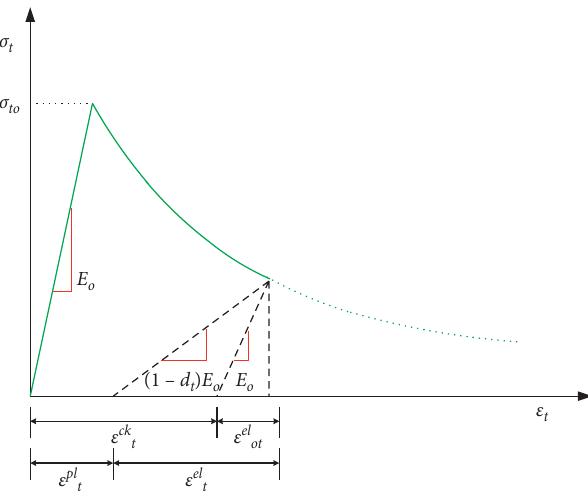
Figure 5: Stress-strain behavior of HFRC under